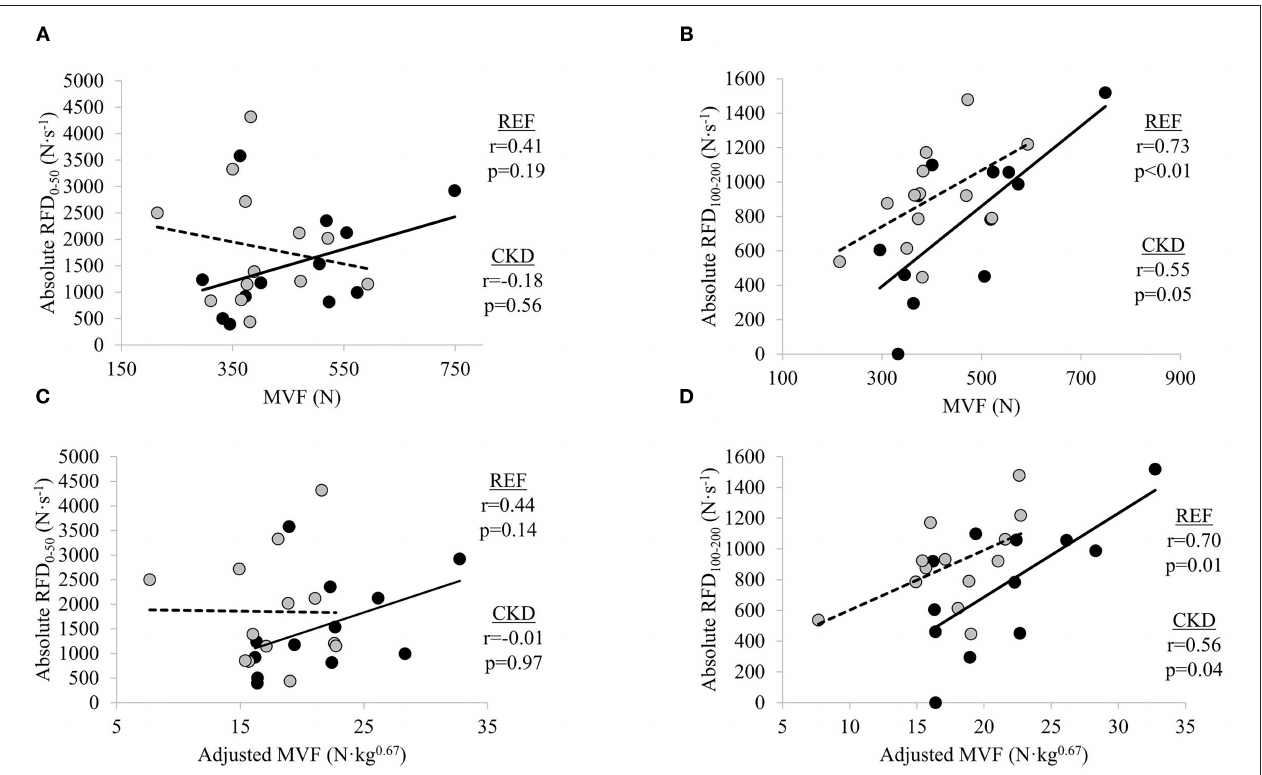
FIGURE 1 | Relationships between absolute rate of force development (RFD) and maximal voluntary force (MVF) at time intervals (A) 0–50ms and (B) 100–200ms, and absolute RFD and adjusted MVF at time intervals (C) 0–50ms and (D) 100–200ms. Gray circles and dashed lines represent patients with chronic kidney disease stages (CKD) 3b and 4 not on dialysis (CKD) while solid circles and lines represent reference participants (REF). N , newtons; N · s − 1 , newtons per second. Significance level set at p ≤ 0.05. N · kg 0.67 , newtons per kilogram to the two-thirds